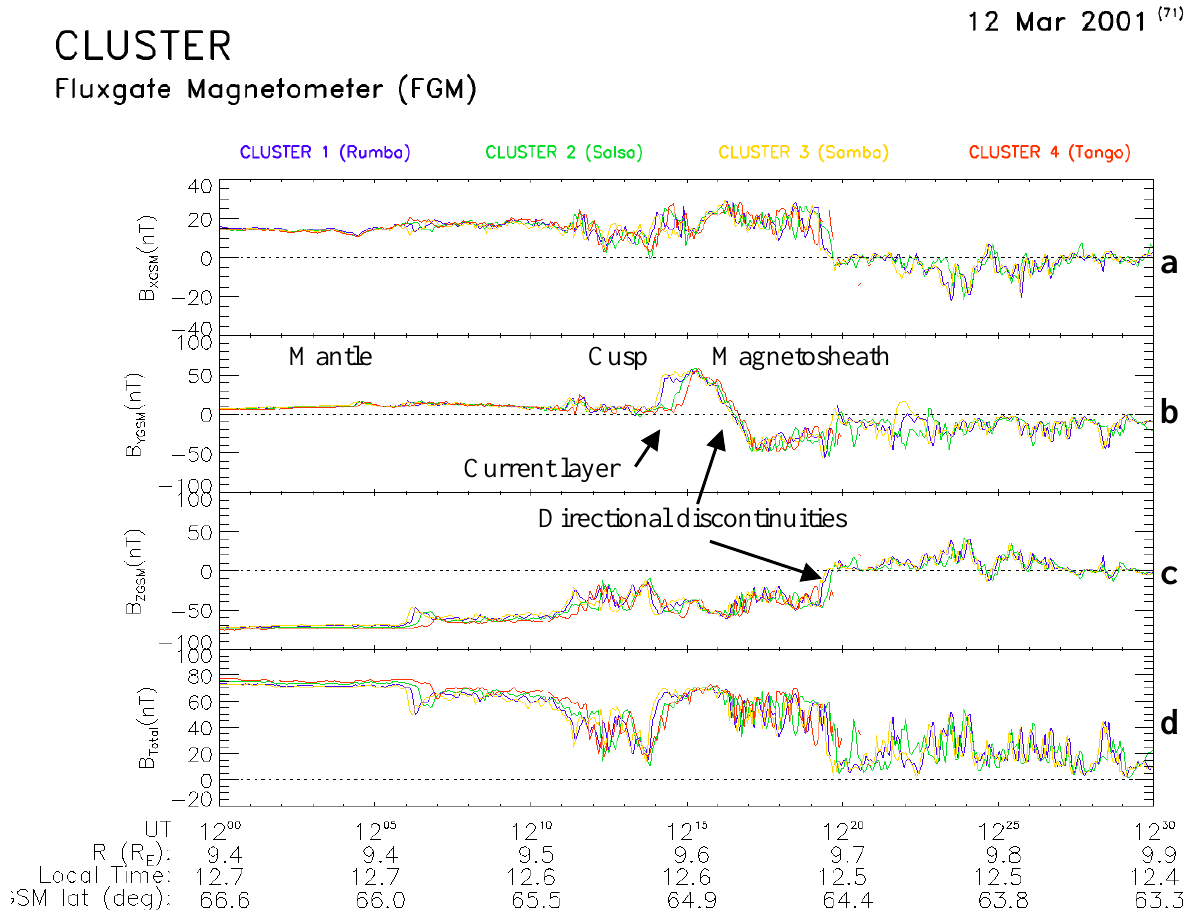
Fig. 10. Cluster magnetic field measurements showing the components and magnitude during the passage of the satellites above the cusp. Color codes for the traces are given at the top. Particular features discussed in the text are